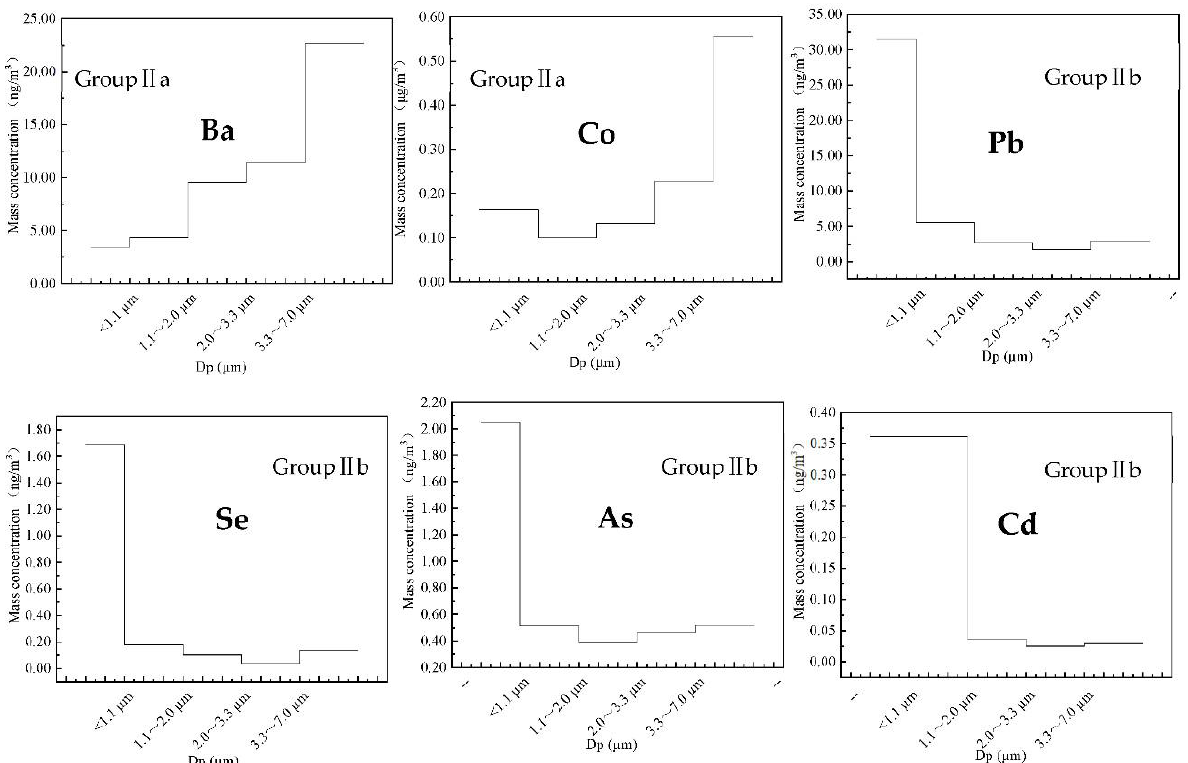
Figure 5. Potentially toxic metals with particle size-bimodal distribution. ( a ) Group I a is the mass concentration mainly concentrated in PM >7.0 ; ( b ) Group I b is the mass concentration mainly concentrated in PM 1.1 .